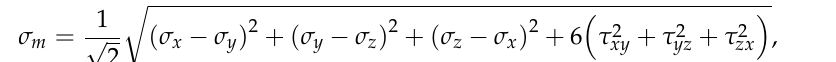
Figure 6. Dislocation and defect mesh in the fracture process of SiNW under three strain rates: ( a ) and ( a1 ) 10 − 2 /ps; ( b ) and ( b1 ) 10 − 4 /ps; ( c ) and ( c1 ) 10 − 6 /ps. The atoms were removed for clarity.